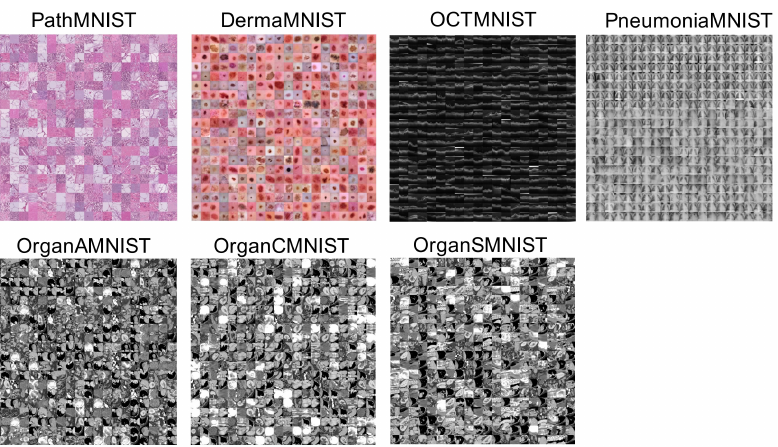
Figure 2. An Overview of the Datasets: PathMNIST, DermaMNIST, OCTMNIST, PneumoniaMNIST, OrganMNIST_Axial, OrganMNIST_Coronal, and OrganMNIST_ Sagittal.